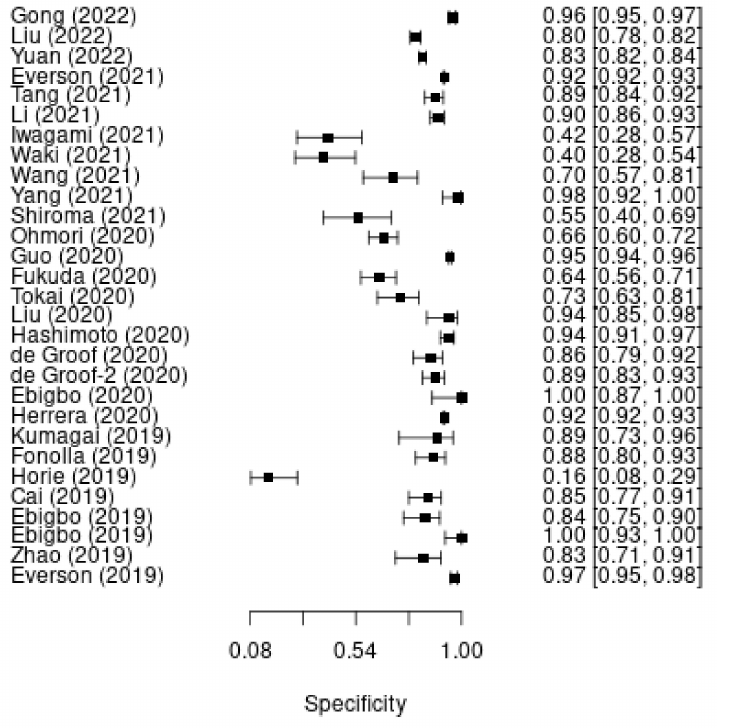
Figure 2. Pooled specificity of the DL model for the diagnosis of esophageal